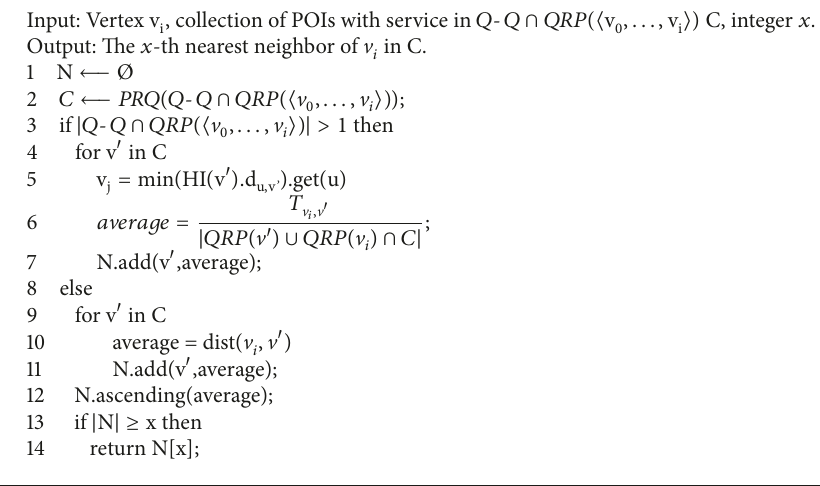
Algorithm 2: FindNN(v i